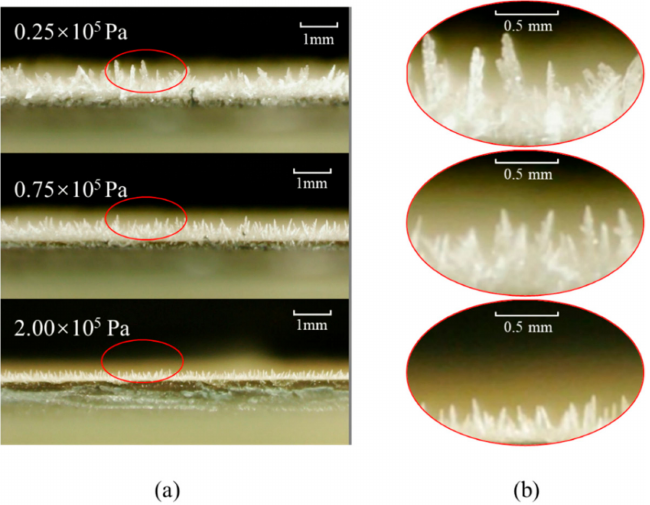
Figure 5. ( a ) Morphologies and ( b ) local details of frost crystals under different working pressures around the cooling